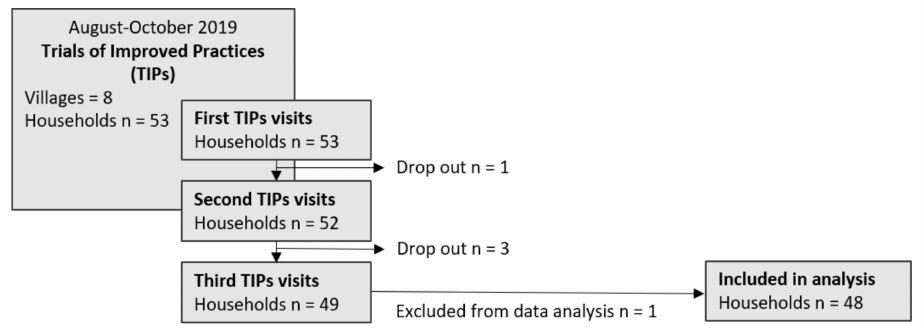
Figure 3. Study flow and drop-out rates of the Trials of Improved Practices